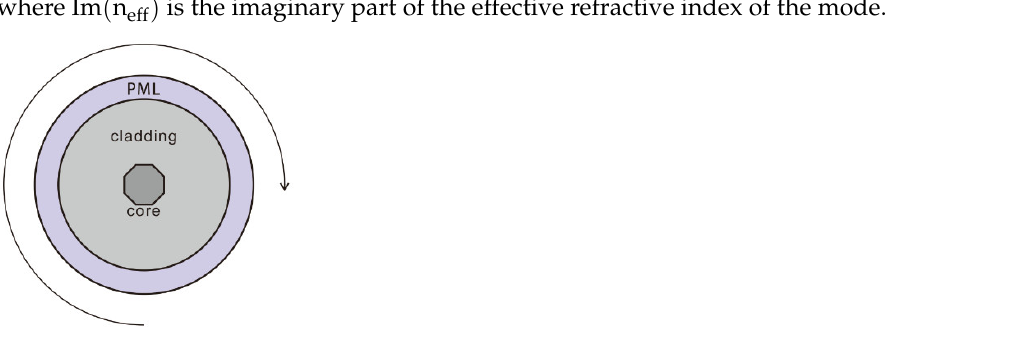
Figure 1. FEM model of the twisted polygon-shaped (octagon) core fiber. The round arrow indicates the twisting